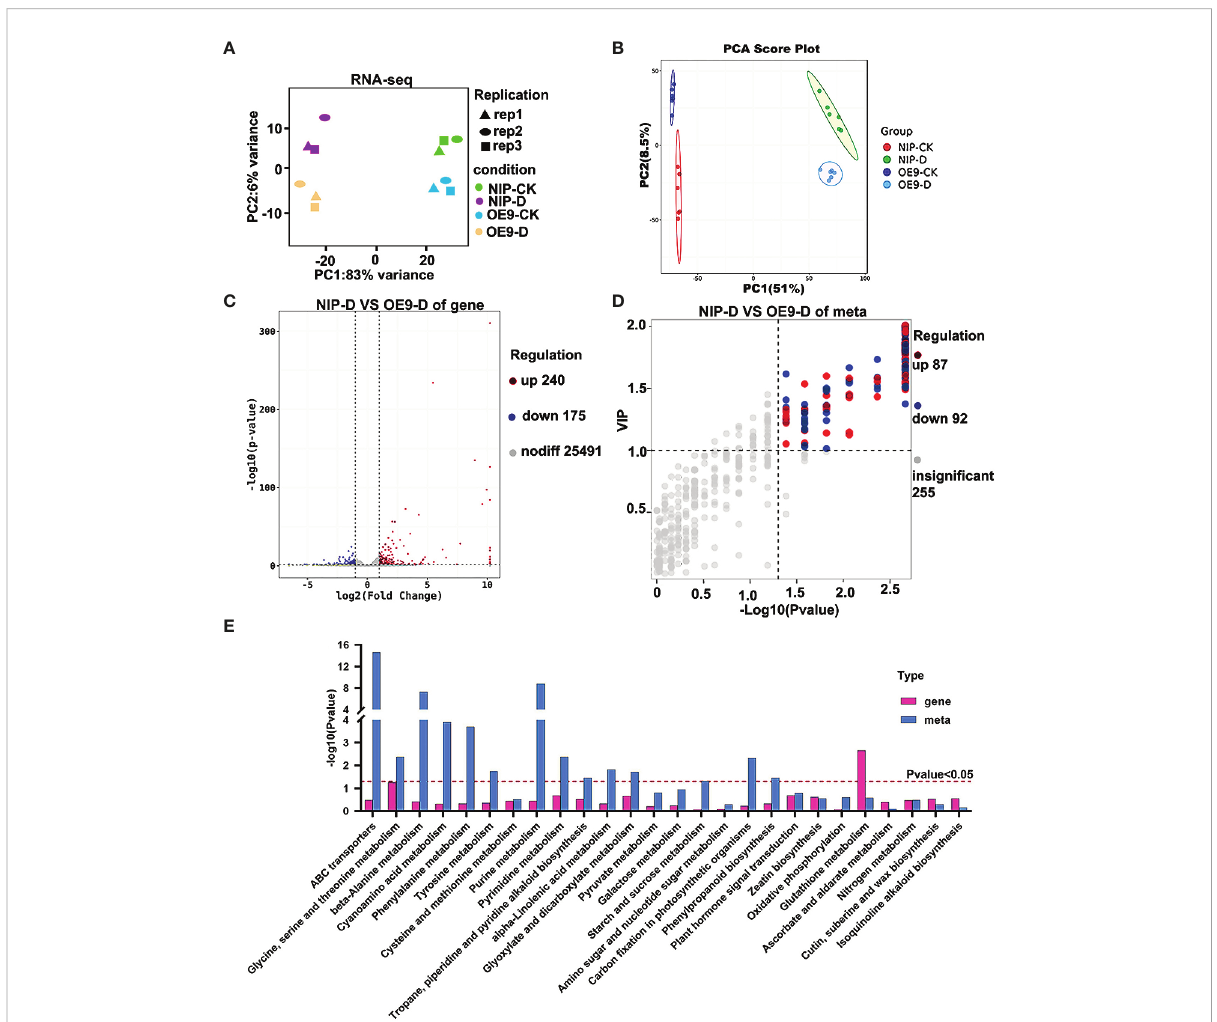
FIGURE 3 PC biplot of the transcriptome and metabolome of rice seedlings under drought stress and identi fi cation of differentially expressed genes and metabolites. (A) PC biplot of transcriptome. (B) PC biplot of metabolome. (C) Volcano plot of differentially expressed genes between NIP and OsCIPK17 -OE9 under drought treatment. (D) Volcano plot of differentially expressed metabolites between NIP and OsCIPK17 -OE9 under drought treatment. (E) KEGG analysis of differentially expressed genes and metabolites between NIP and OsCIPK17 -OE9 under drought treatment. CK means control check, which means growth under normal conditions without drought treatment. D means under drought treatment. OE9 means OsCIPK17 overexpression line 9. NIP-D, NIP-CK, OE9-D, and OE9-CK mean combination of lines and treatment methods. The same meaning as the following fi